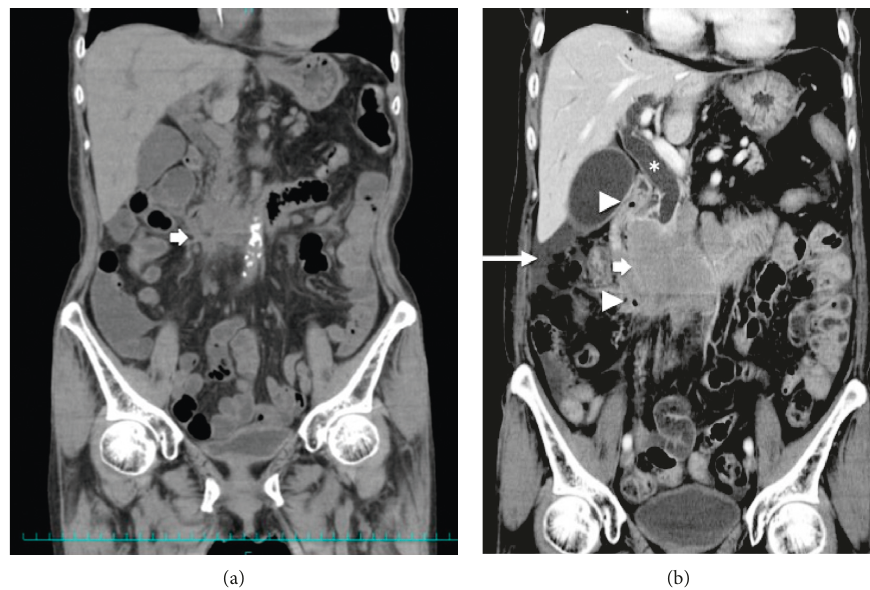
Figure 1: Contrast abdominal CT (coronal) image upon admission. The scan shows (a) prominent thickening of the duodenal wall from the second to third portion (arrow), and (b) perforation 17 days after gastrojejunostomy revealing an enlarged duodenal mass (arrow), free air (arrow heads), ascites (long arrow), and expansion of the common bile duct/intrahepatic bile duct ( ∗ ) due to tumor-related stenosis.